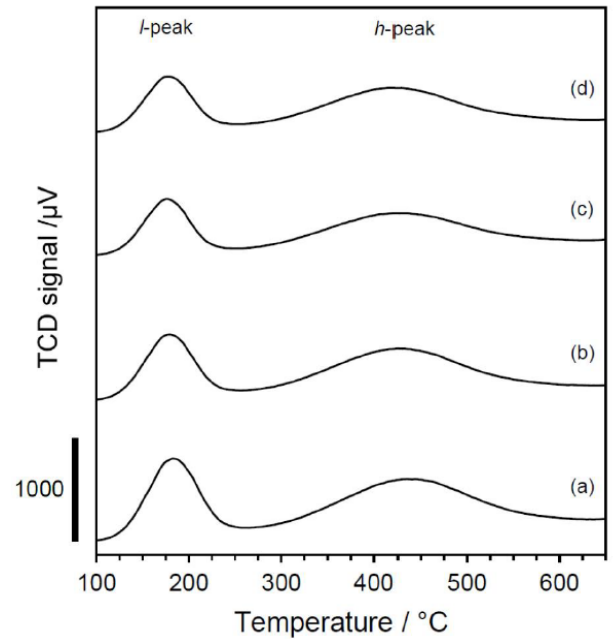
Figure 5. The NH 3 -temperature programmed desorption profiles for the (a) deAl-YFI-A(51), (b) deAl-YFI-B(57), (c) deAl-YFI-C(55), and (d) deAl-YFI-D(63). The acid concentrations determined from the h peaks are (a) 0.258, (b) 0.290, (c) 0.224, and 0.249 mmol·g −1 , respectively. The Al levels determined by ICP analysis are (a) 0.325, (b) 0.319, (c) 0.267, and 0.301 mmol·g −1 , respectively. As explained in Section 2.4, the dealuminated versions of YFI-A, B, C, and D are referred to herein as deAl-YFI-A, B, C, and D( n ), respectively, where n indicates the Si/Al ratio.